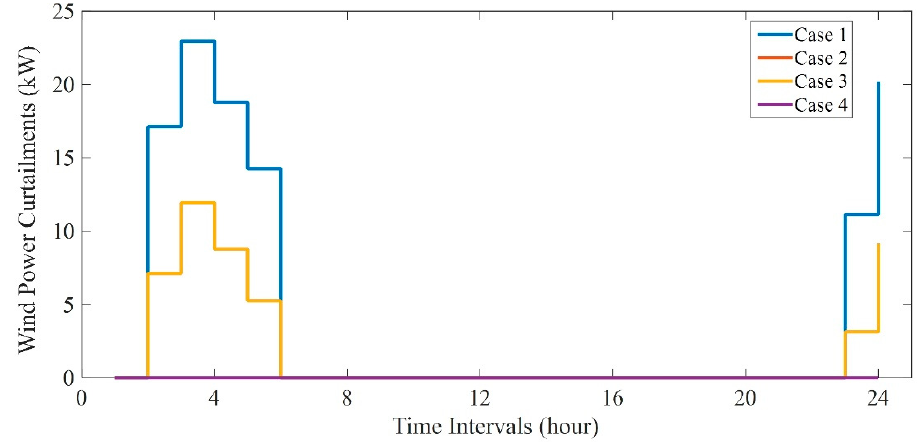
Figure 9. The wind power curtailment in Case 1-4 on the typical summer